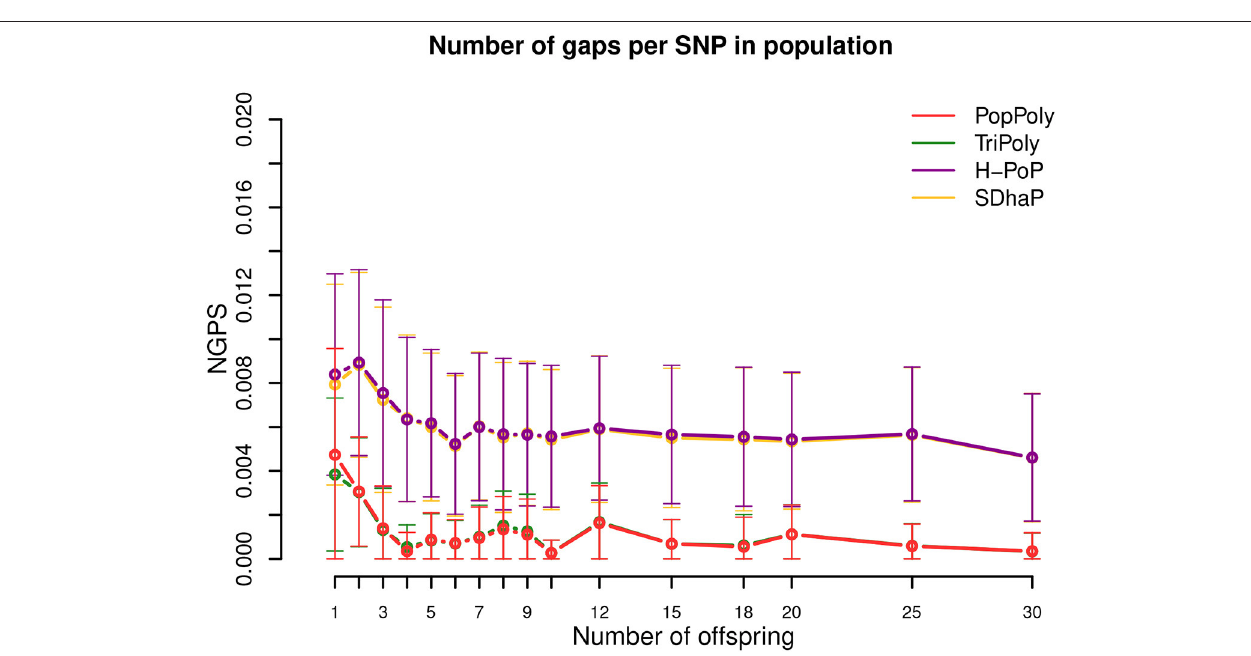
FIGURE 5 | Number of phasing gaps normalized per SNP (NGPS) in the haplotype estimates of PopPoly (red), TriPoly (green), H-PoP (purple), and SDhaP (yellow) against the number of offspring in the population for simulated tetraploid potato populations.